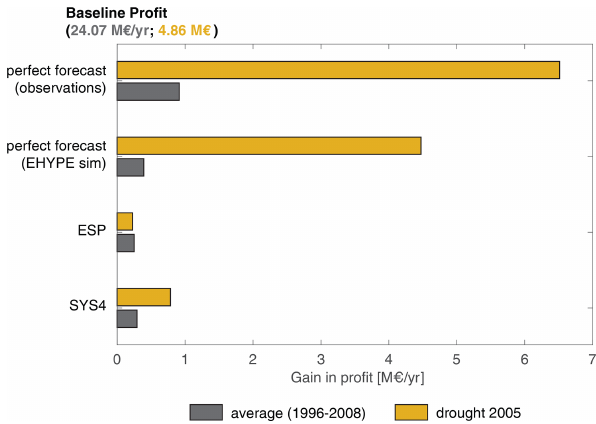
Figure 5. Comparison of gains in farmers’ profit with respect to the baseline solution under different Lake Como operating policies in- formed with ESP and SYS4 forecasts, along with the upper bound of the system performance (perfect inflow forecasts from observa- tions or the E-HYPE